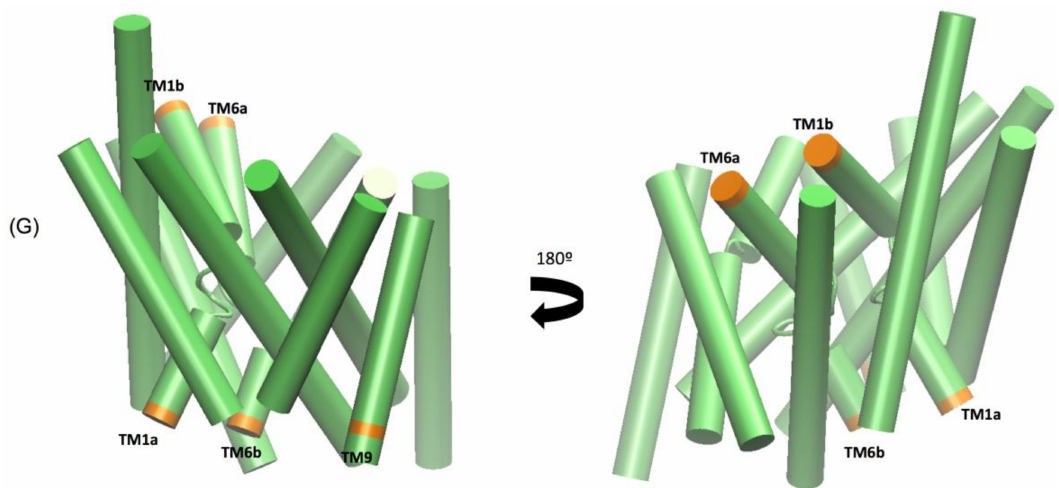
Figure 6. Time evolution in the simulations for rDAT when bound to DPH ( A – C ) and 2-MXP ( D – F ). ( A , D ) depict the distances between D79 and Y156, Na1 and Na2 and R85 and D475. ( B , C , E , F ) panels depict the C β -C β distances between residues in various extracellular and intracellular transmembrane (TM) segments respectively for I67 (in TM1a) and L446 (in TM9), I67 (in TM1a) and S332 (in TM6b) and S332 (in TM6b) and L446 (in TM9); E306 (in TM6a) and F171 (in TM3); and F171 (in TM3) and K92 (in TM1b). (G) The IC and EC segments in the protein TM regions from the middle and bottom panels are labelled and coloured in